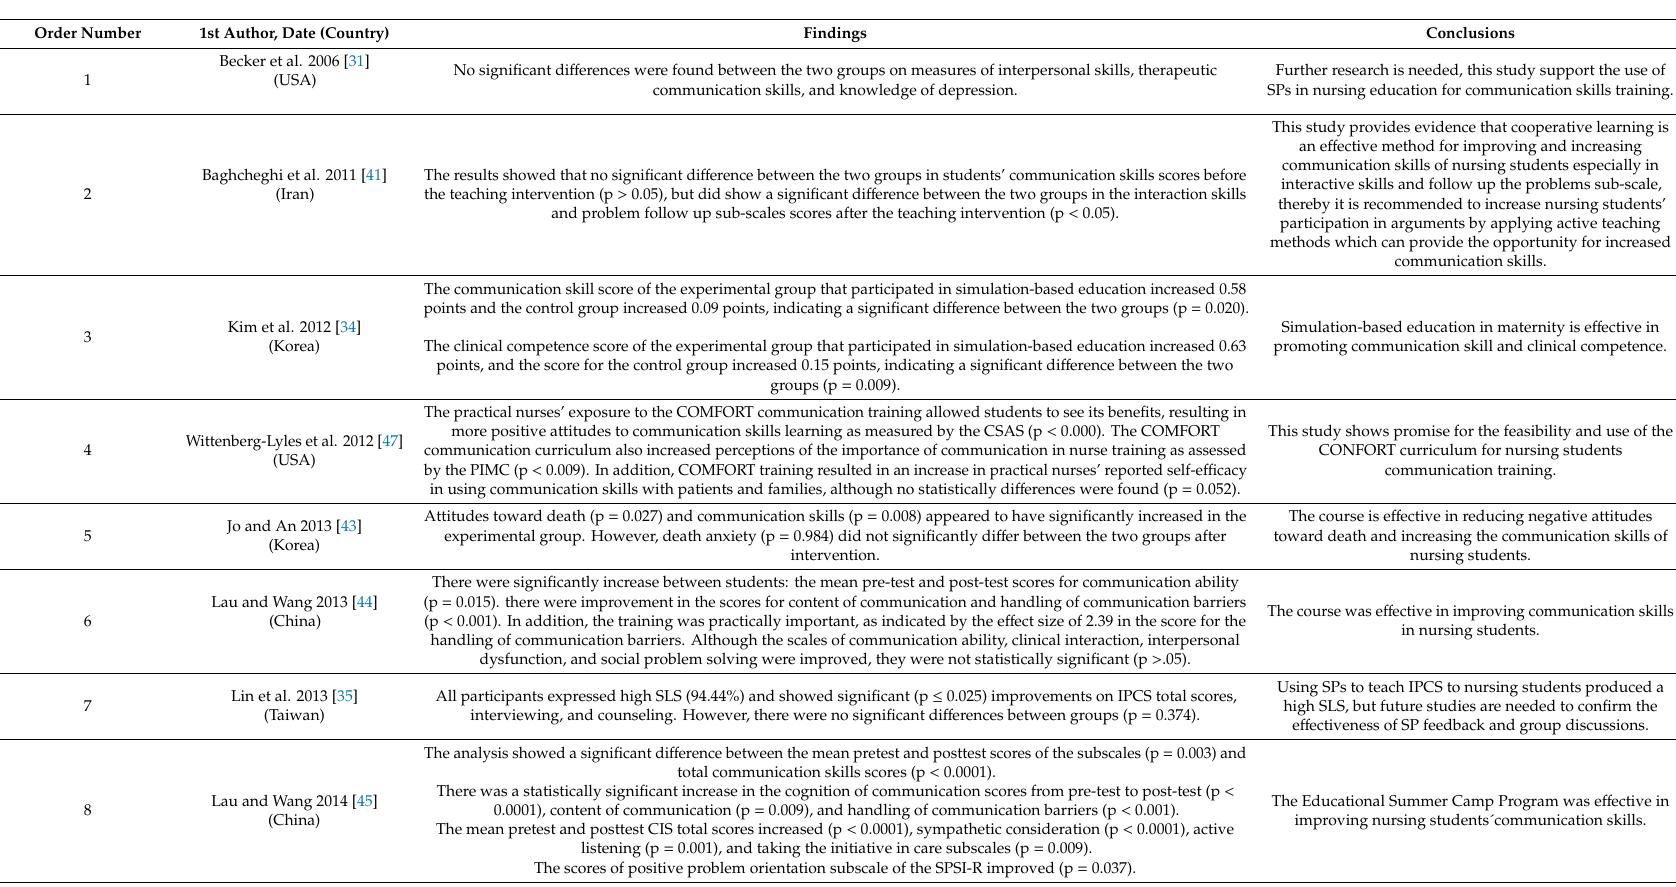
Table 3. Main results and